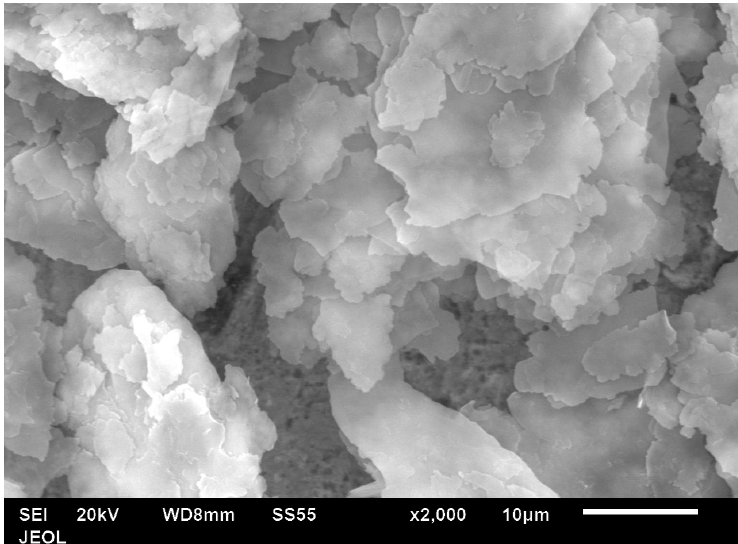
Figure 2. SEM image of Al nano platelet particles .